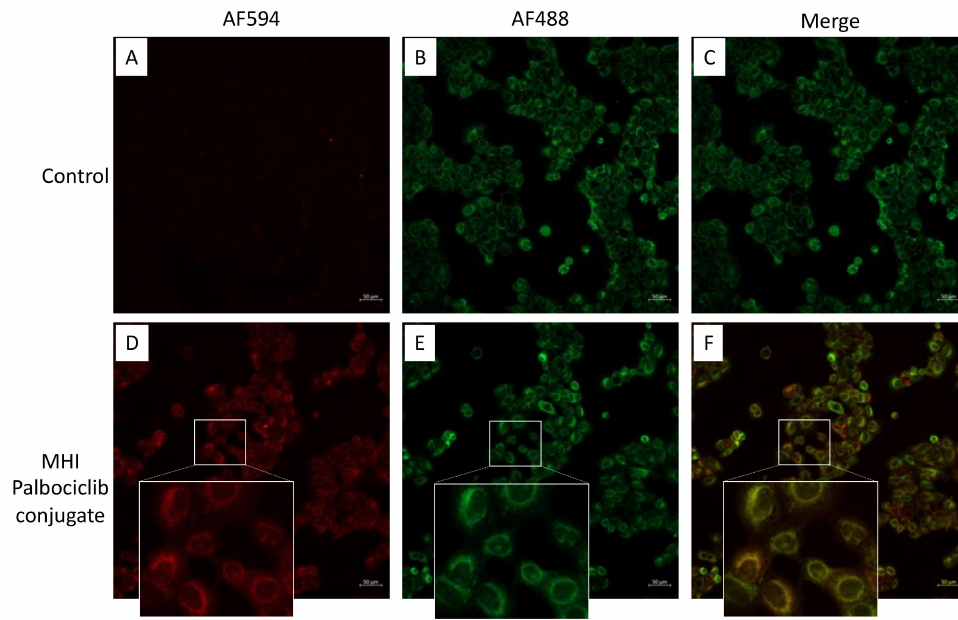
Figure 6. MHI-palbociclib localized in mitochondria. Red fluorescence (MHI-palbociclib) ( A , D ) and green fluorescence (Mitotracker Green) ( B , E ) were captured using confocal microscopy. DMSO was used as control. ( C ) Merged image of ( A , B ) using DMSO as control. ( F ) Merged image showing MHI-palbociclib (red) co-localized in mitochondria (Mitotracker Green). Scale bar: 50 µ m.